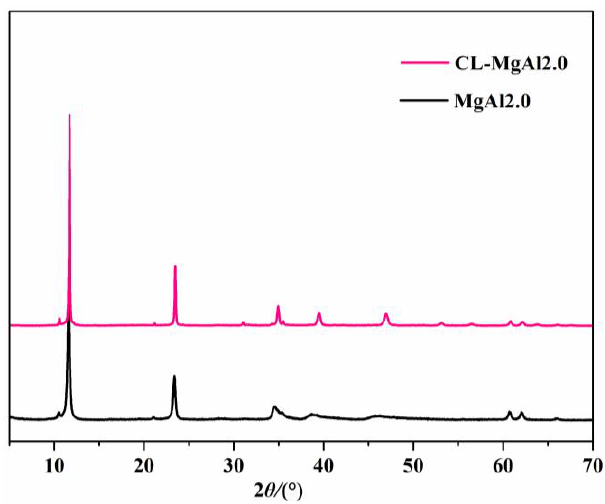
Figure 8. The XRD pattern of MgAl2.0 and its crosslinked counterpart (CL-MgAl2.0). The desorption peak temperature of MgAl2.0 was 20 ◦ C lower than that of crosslinked CL-MgAl2.0, while the peak area of MgAl2.0 was much larger than that of its crosslinked counterpart (Figure 9 and Table 3). This suggests that crosslinking has increased the strength of the basicity and reduced the surface basicity of the LDHs.